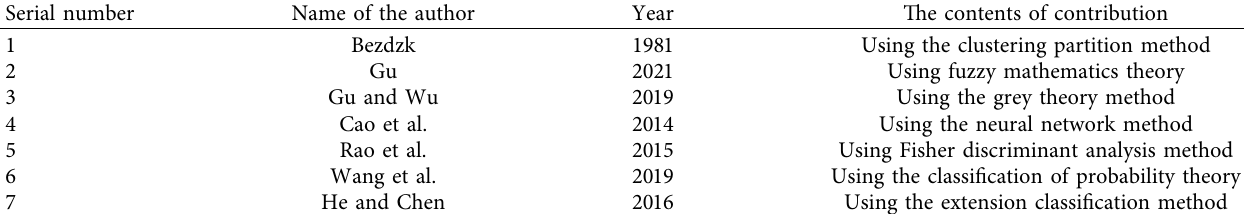
Table 1: The contribution list of different